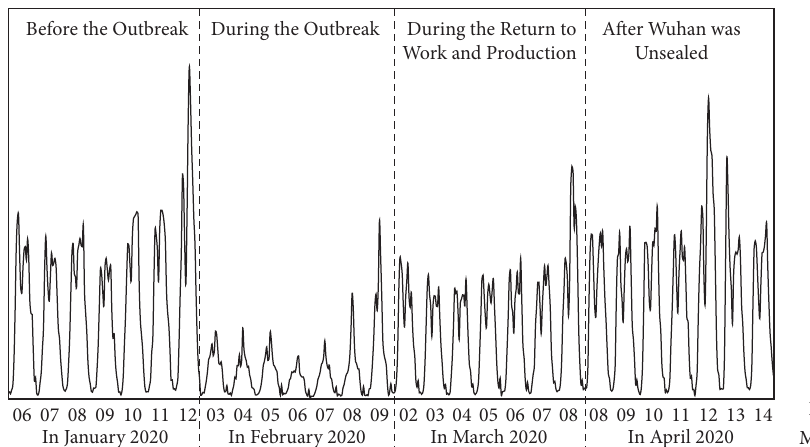
Figure 5: Intercity highway OD flows between Hefei and Lu’an in four different time periods.